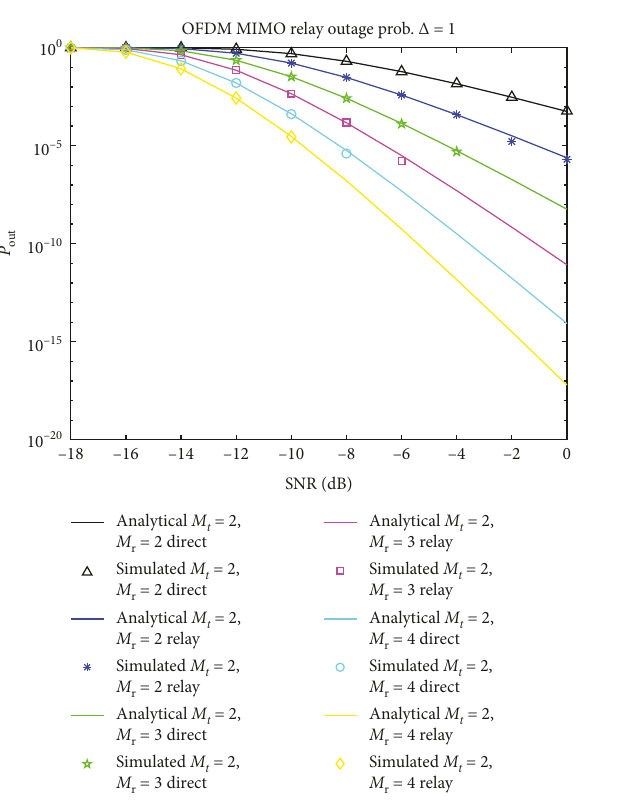
Figure 6: BER performance with MIMO-OFDM direct and relay ( Δ �